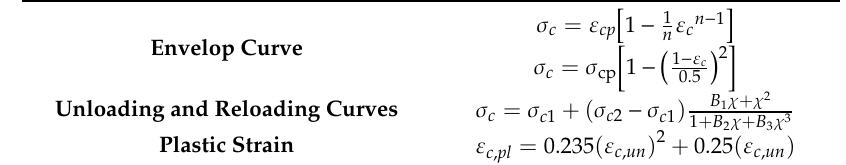
Table 5. Constitutive model for masonry under cyclic compression: Facconi et al.